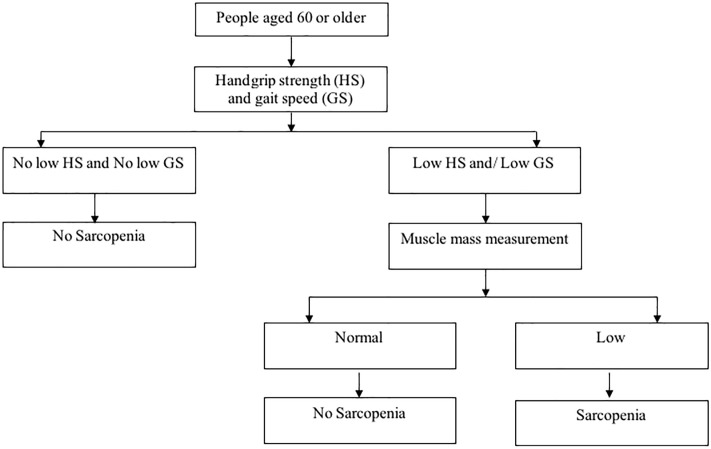
Algorithm for diagnosing sarcopenia adopted from Asia Working Group for Sarcopenia [2].